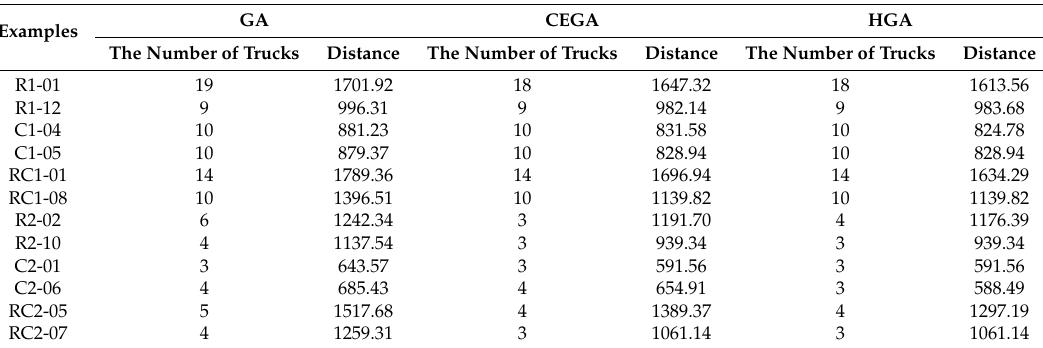
Table 2. Experimental results of HGA and other algorithms.